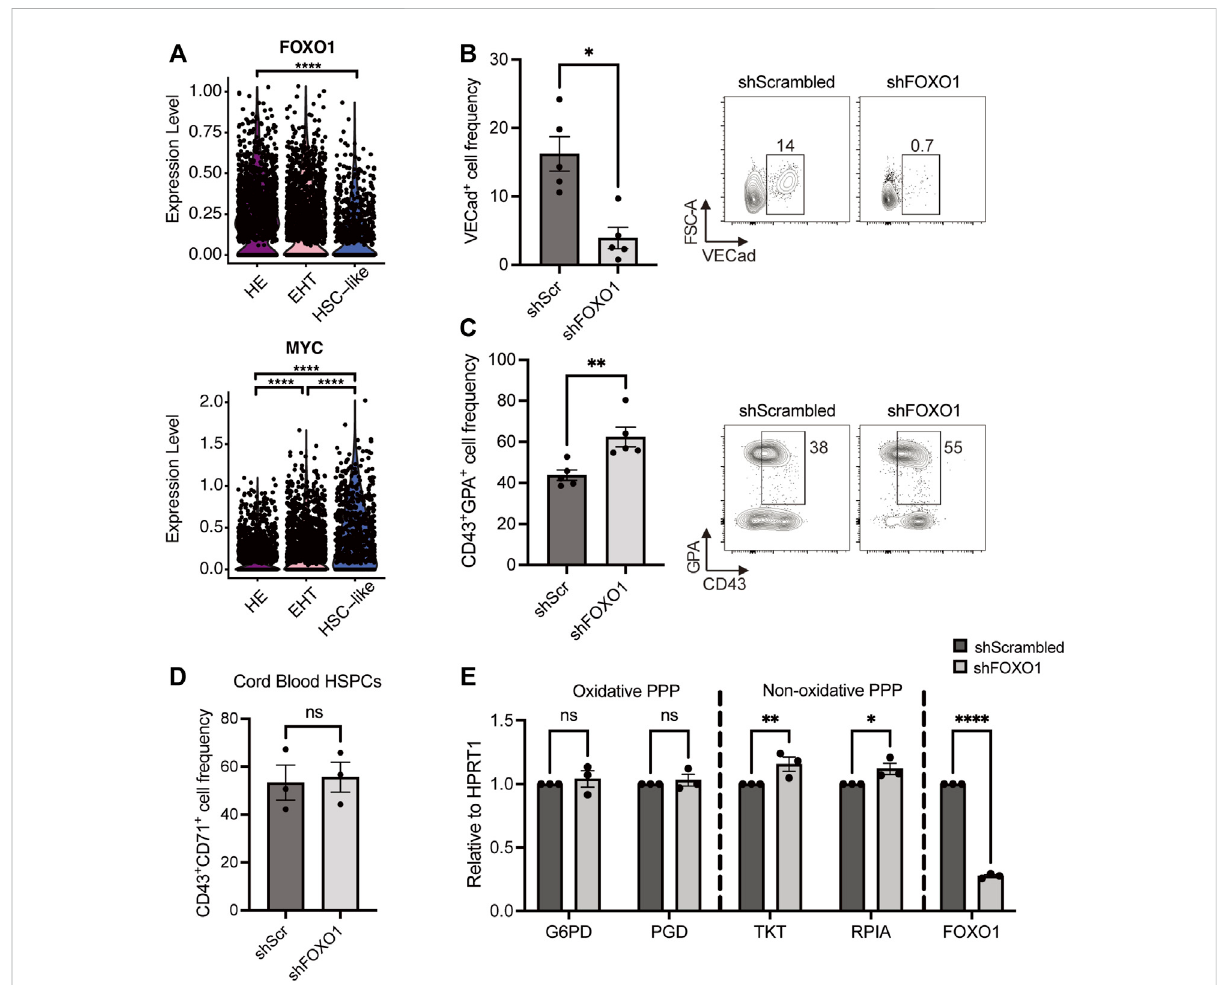
FOXO1 knockdown increases HE-derived erythroid cell output and upregulates the non-oxidative pentose phosphate pathway. (A) Violin plots showexpressionlevelsof FOXO1 and MYC forHE,EHTandHSC-likecellsfromourpreviouslypublisheddataset, asdetectedbyscRNAseq(Negative binomial regression tests). (B,C) iPSC-derived HE cells were transduced with lentivirus with shRNAs targeting FOXO1 or a control scrambled shRNA (shScr) and subcultured for 6 days. Representative plots and bargraphsshowing VECad + cell frequency ± SEM (B) CD43 + GPA + cellfrequency± SEM (C) at day 6 are presented ( n = 5, paired t -tests). (D) Umbilical cord blood-derived HSPCs were transduced with the indicated shRNA-harboring lentivirus 2 days after isolation. Bar graphs show CD43 + CD71 + cell frequency ± SEM after 3 days of erythroid differentiation ( n = 3, paired t -tests). (E) iPSC-derived HE cells were transduced with lentivirus with shFOXO1 or shScr and subcultured for 3 days. Day 3 transcript levels of pentose phosphate pathway enzymes relative to HPRT1 are shown ( n = 3, 2-way ANOVA). ns, not signi fi cant, * p < 0.05, ** p < 0.01, **** p <